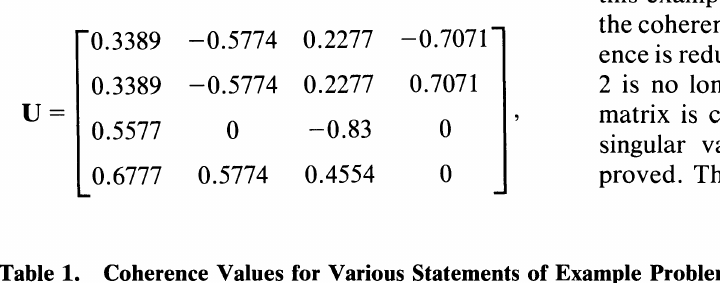
Table 1. Coherence Values for Various Statements of Example